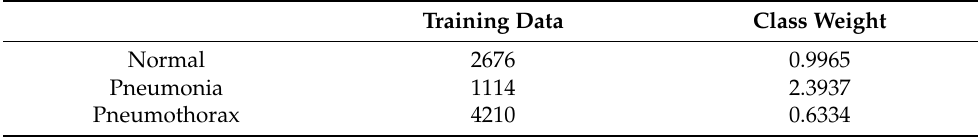
Table 5. NIH data set weights by disease type.